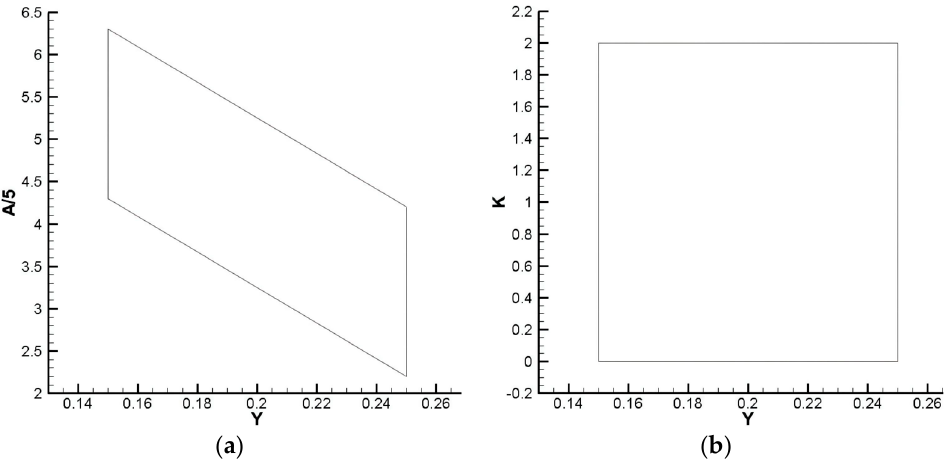
Figure 11. Value range of three parameters. ( a ) Y and A/5 ( b ) Y and K. Table 7. Range of variations for each variable.